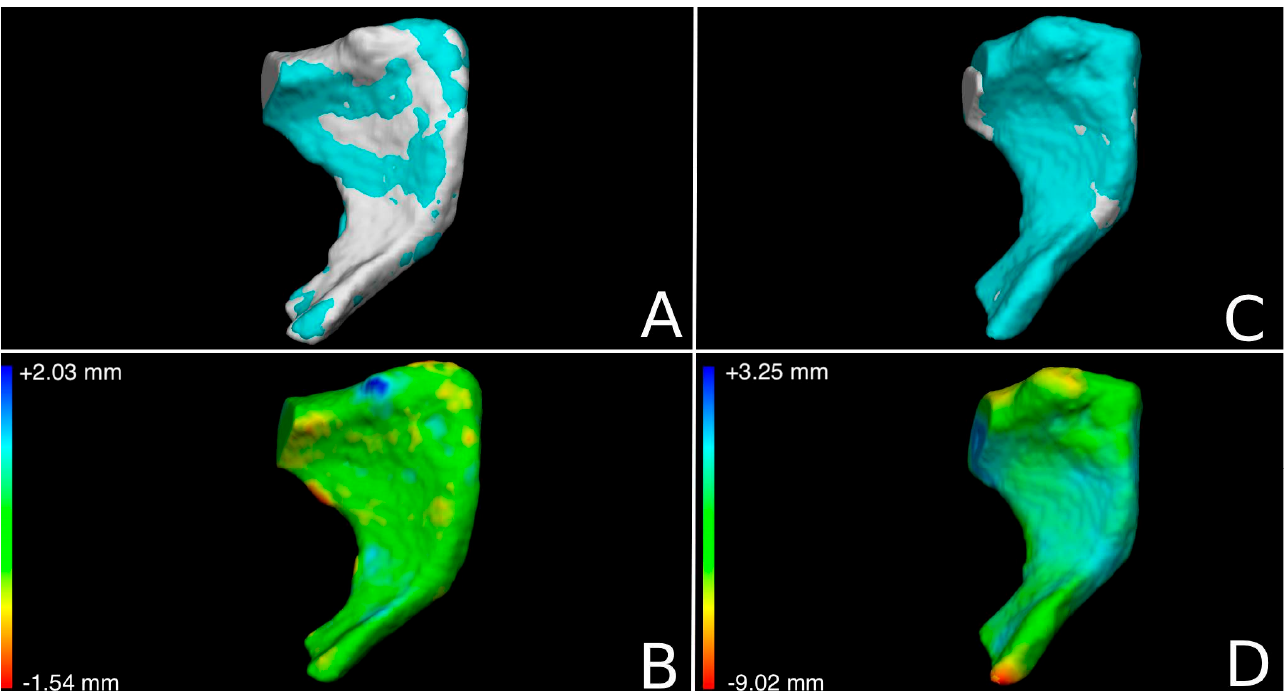
Figure 1. Superimposition and calculation of the point-to-point distance between two models. ( A , B ): superimposition left-on-right model from the same subject. ( C , D ): superimposition of the left-on-right model from different subjects. ( A , C ): the light blue model is the mirrored left pubic bone and the grey one is the right pubic bone. ( B , D ): the green areas indicate coincident points on the models. In blue, the receding areas of the left pubic bone according to the right pubic bone. In red, orange, and yellow are the prominent areas of the left pubis according to the right pubis. ( B ): example of the chromatic map of a true pair match. ( D ): example of the chromatic map of a mismatch.